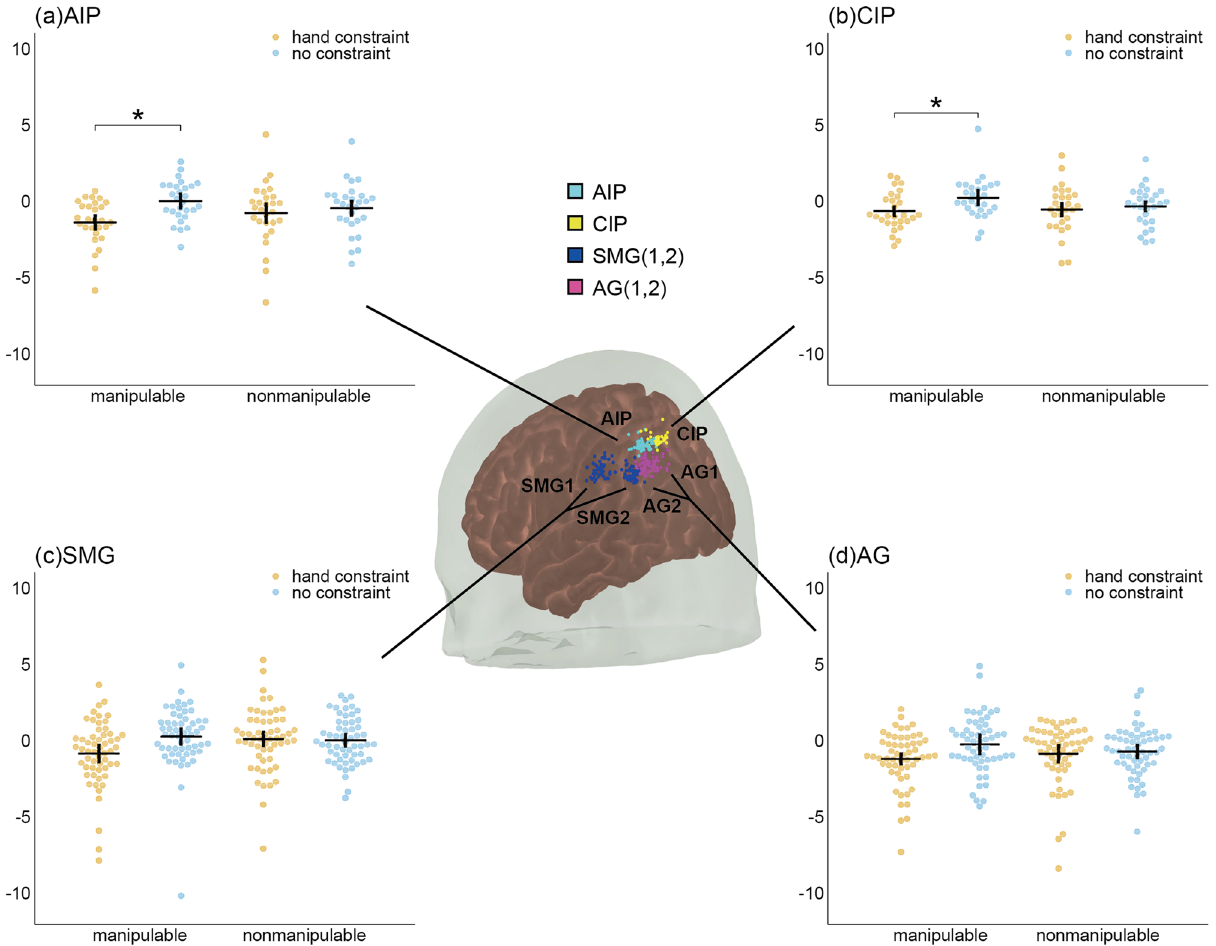
SMG (supramarginal gyrus, BA 40) and ( d ) AG (angular gyrus, BA 39). Each participant’s mean z score of the hemodynamic responses in the size judgment task is shown. The orange (hand constraint) and blue (no constraint) dots indicate the mean z score of each participant’s hemodynamic response during the task (n = 28). Means are presented by horizontal lines. Vertical lines indicate the 95% confidence intervals calculated after subtracting the random effects of participants according to the Cousineau–Morey method 52,53 . The color of each group of dots on the brain displays the positions of the channels of each participant in the Montreal Neurological Institute (MNI) coordinates. In SMG and AG, the data from two channels are displayed. FDR corrections were applied to the post hoc t tests to control for multiple comparisons. *p <